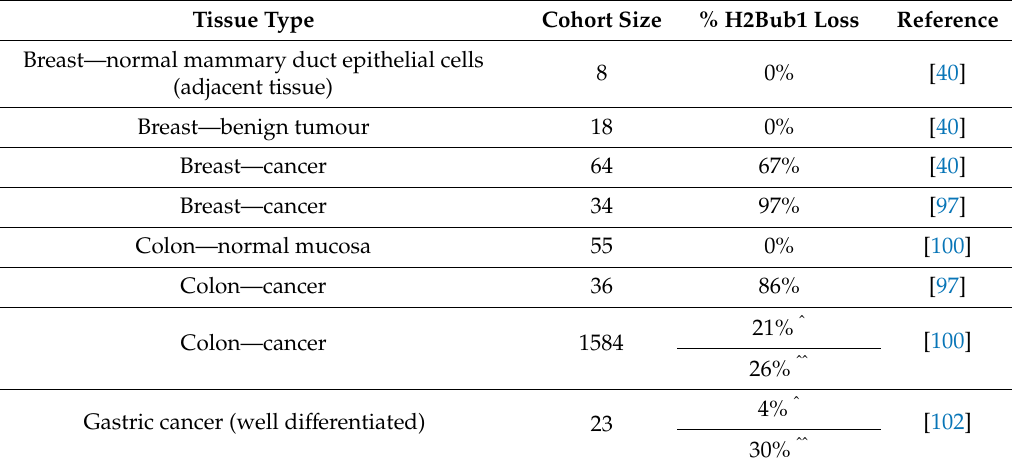
Table 1. H2Bub1 loss in primary